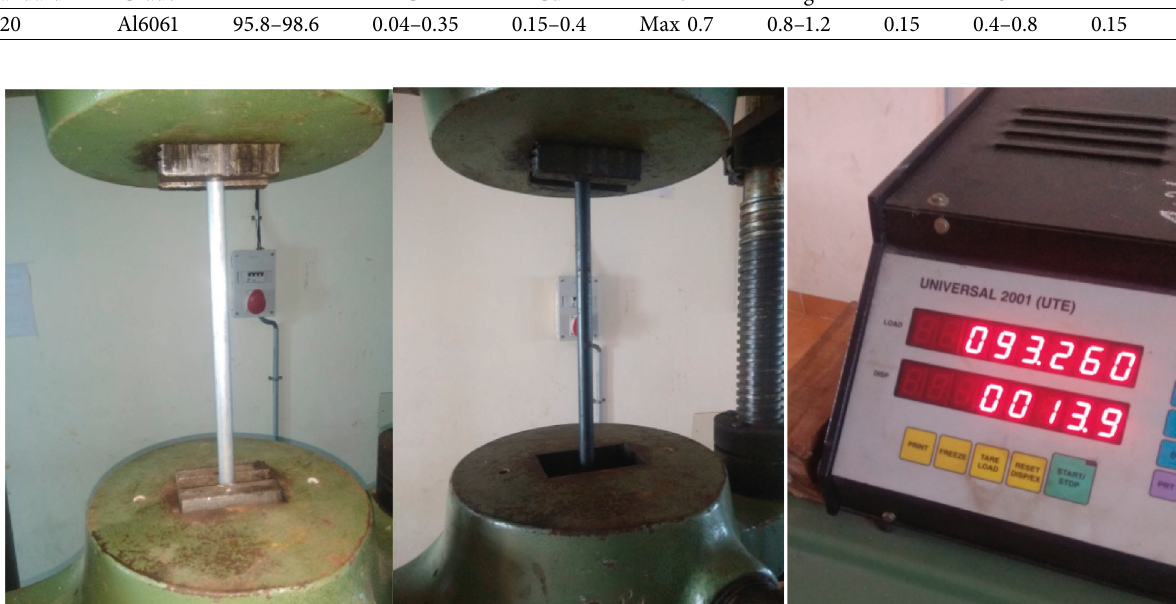
Figure 2: Tensile testing of steel and aluminum alloy.